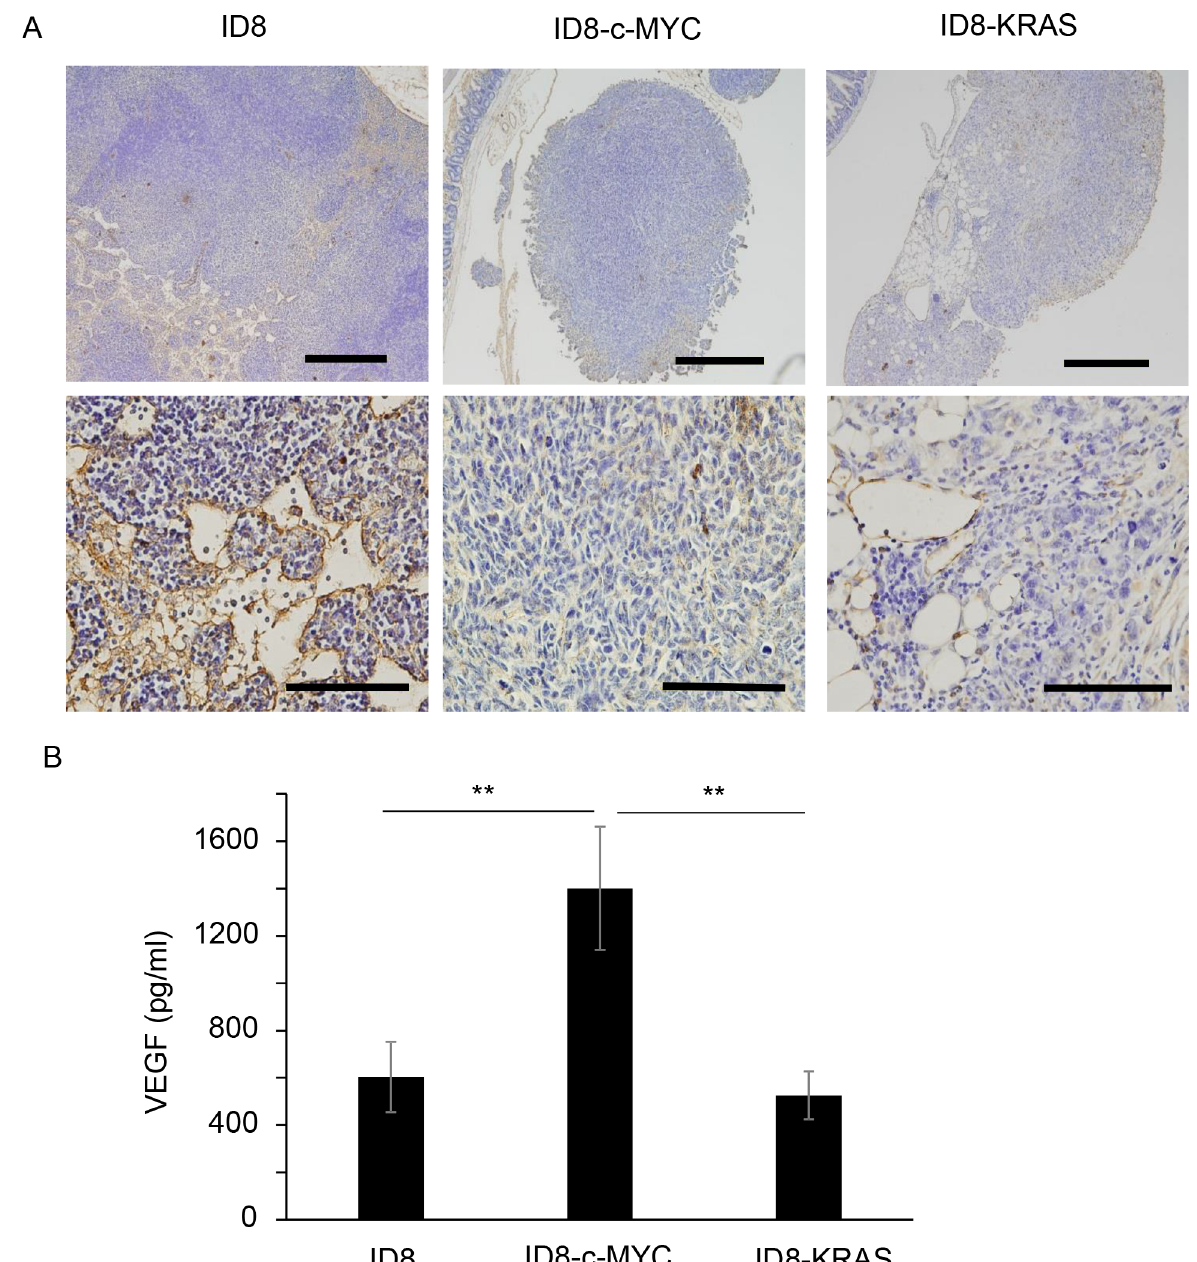
Fig 2. Tumor vascularization and VEGF in ascites. (A) ID8, ID8-c-MYC, or ID8-KRAS cells (2 × 10 6 ) were intra-peritoneal injected into C57/BL6 mice. Mice were sacrificed when the body weight reached 23 g. Disseminations were obtained from mice when sacrificed. Tumor vascularization of each dissemination was assessed using CD-31 immunohistochemistry (IHC). Scale bars represent 200 μ m and 50 μ m at low and high magnification, respectively. (B) ID8, ID8-c-MYC, or ID8-KRAS cells (2 × 10 6 ) were intra-peritoneal injected into C57/BL6 mice. Mice were sacrificed when the body weight reached 23 g and ascites were collected (ID8, ID8-c-MYC, and ID8-KRAS: n = 10). VEGF concentration of ascites were assessed with specific ELISA. Error bars represent the mean ± SEM. A statistical analysis was performed with the Student ’ s t-test ( ** P (cid:1)